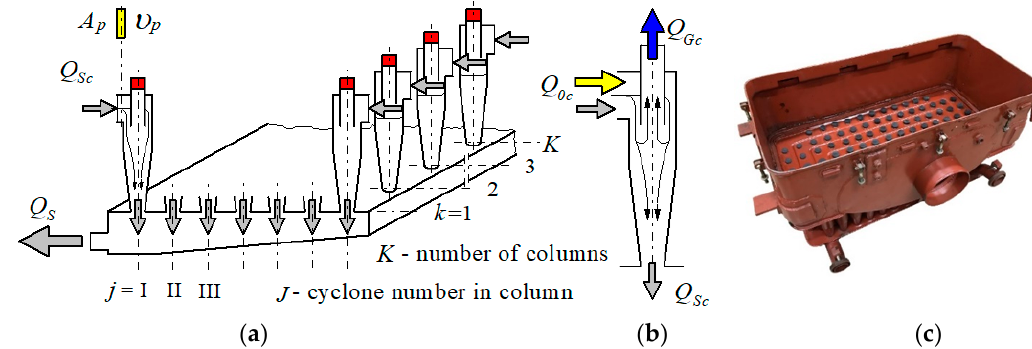
Figure 21. The flow Q Sc in the cyclone: ( a ) during a measurement (I, II, III, ... j .... J is a cyclone serial number in the column— the number of the rows; 1, 2, 3, ...k ...K is the cyclone serial number in the row—the number of the columns, ( b ) during operation, ( c ) a view of the multicyclone with the blocked cyclone outlets.